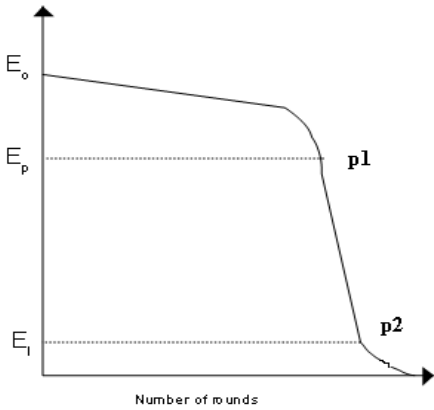
Figure 3. Voltage curve of the battery.